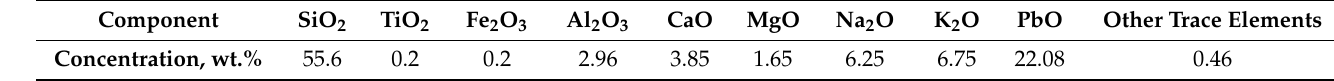
Table 1. Cathode-ray tube (CRT) glass